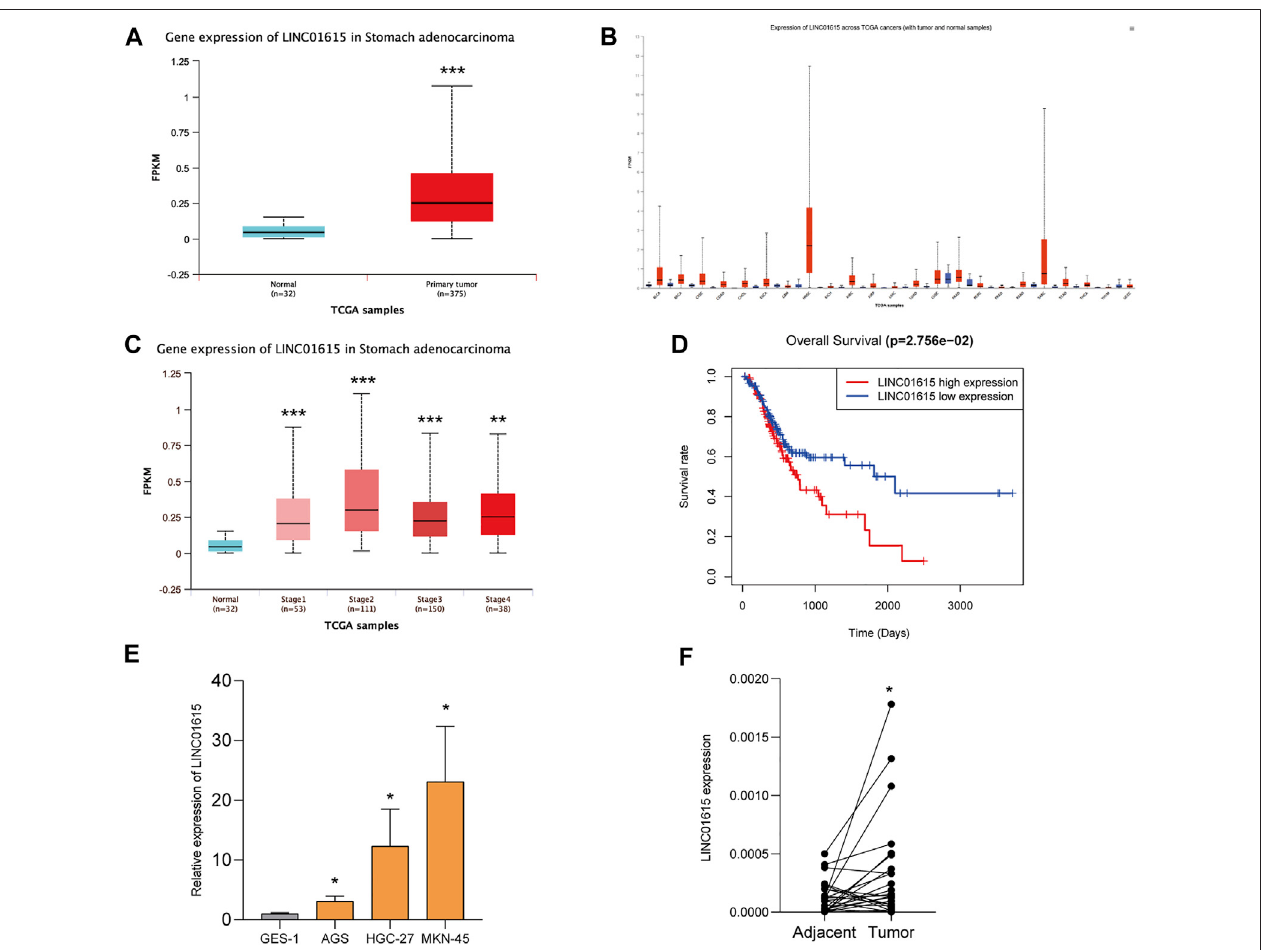
FIGURE 6 | LINC01615 is upregulated in STAD. (A) UALCAN analysis revealed that LINC01615 is upregulated in STAD tumor tissues. (B) Expression of LINC01615acrossTCGAtumors(withtumorandnormalsamples). (C) LINC01615levelsindifferentTNMstages(UALCAN). (D) HighLINC01615expressionpredicted pooroverallsurvivalinSTADpatientsintheentiredataset. (E) LINC01615wasupregulatedingastriccelllines. (F) LINC01615wasupregulatedingastriccancertissues. * p < 0.05, ** p < 0.01, *** p <